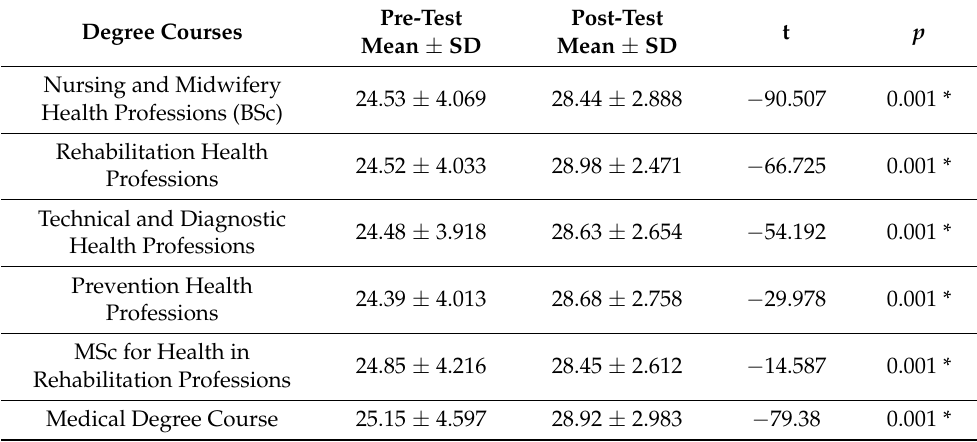
Table 2. Pre-post evaluation (Student’s t-test for paired samples).